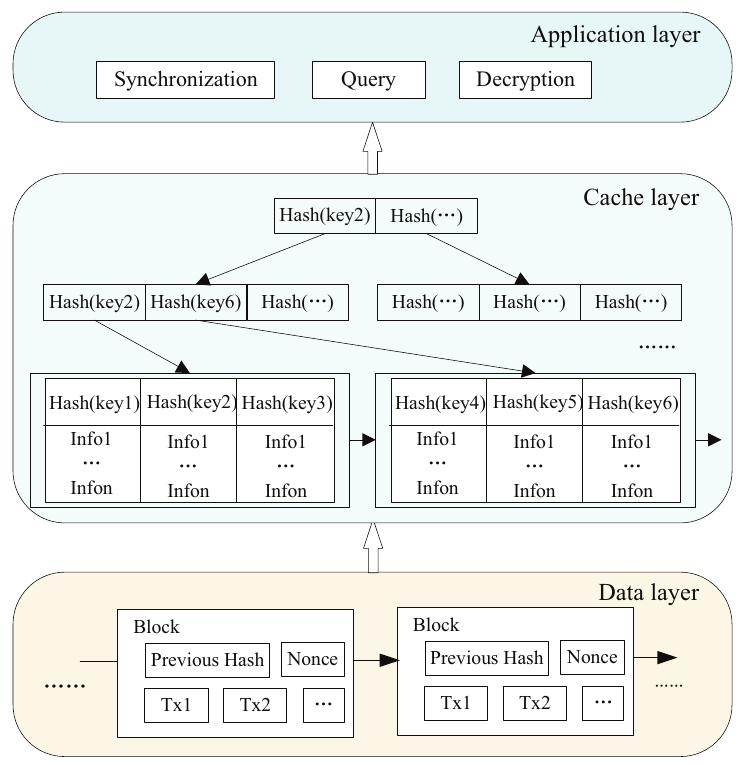
Figure 7. Data query